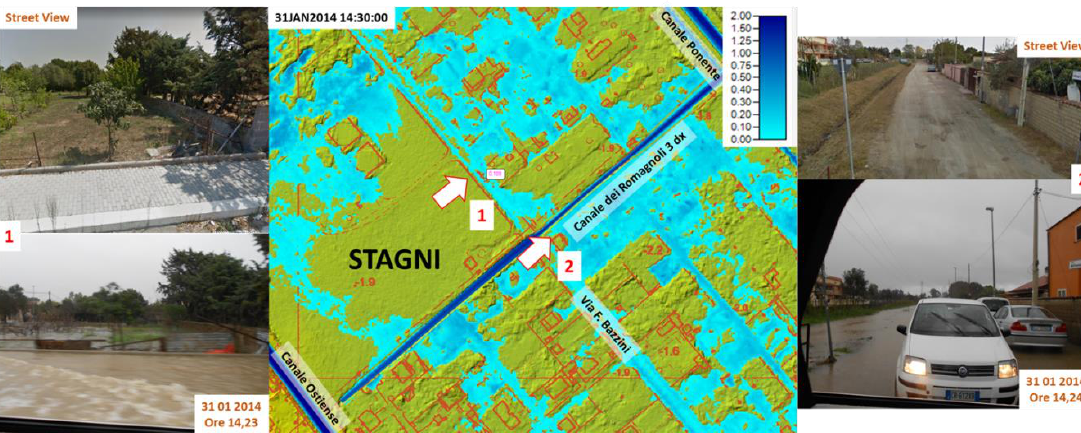
Figure 6. Event of 31 January 2014. Pictures taken during the event at times 14:23 and 14:24 compared with recent photos (from Google Street View, 2016) and the simulated flooding areas at 14:30. The position of the area is represented by the red star symbol in Figure 1d.